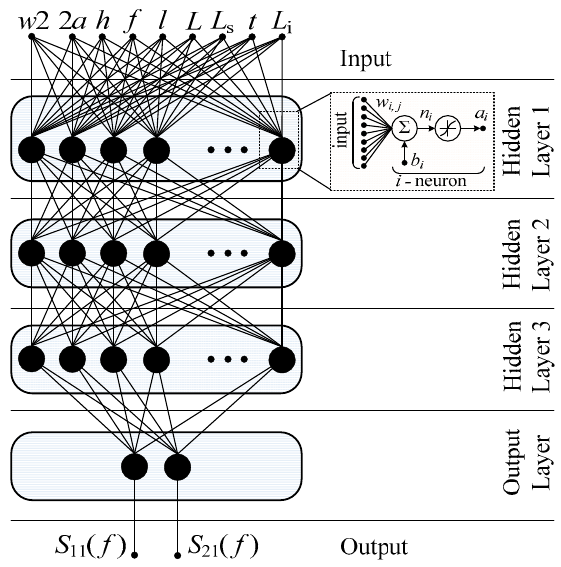
Figure 4. The structure of the feed-forward backpropagation network.